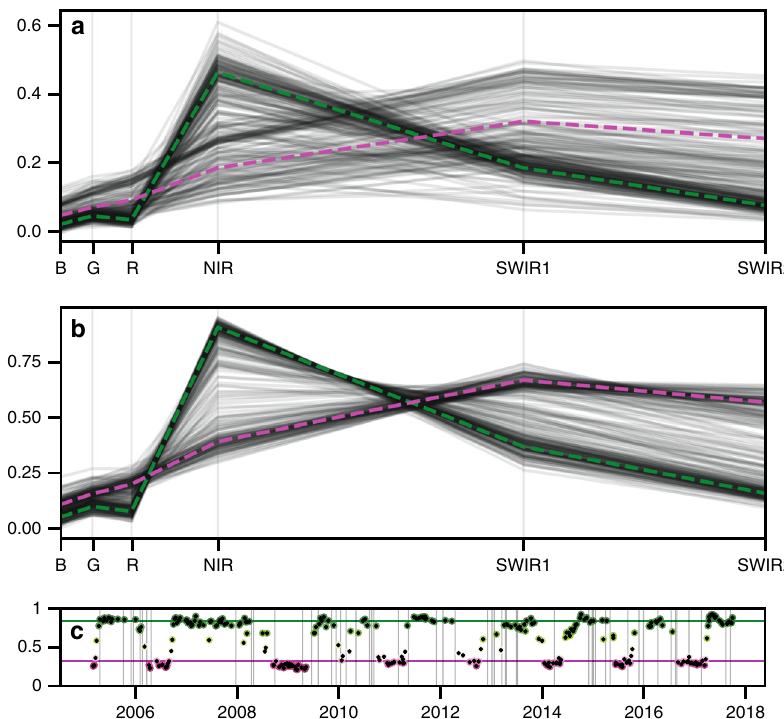
Fig. 3 Spectral responses through time at a speci fi c pixel location compared to the estimated Barest Earth spectra. The pixel location is identi fi ed with tick markers in Fig. 3. The fi rst plot shows the observation spectra through time with the Barest Earth (magenta) and Most Vegated (green) shown with dashed lines, the second plot shows the observation spectra but scaled (as x = jj x jj for observation vector x to remove parallel albedo shifts due to atmospheric effects). The Most Vegated output is generated by inverting the Bare Earth algorithm to get the opposite response. The third plot shows the normalised difference vegetation index (NDVI) time series of the observations coloured using the Barest Earth weighting model. Horizontal lines show the normalised difference vegetation index of the Barest Earth (magenta) and the Most Vegated (green). Vertical lines show the presence of missing data due to cloud masking or LS7 SLC-off